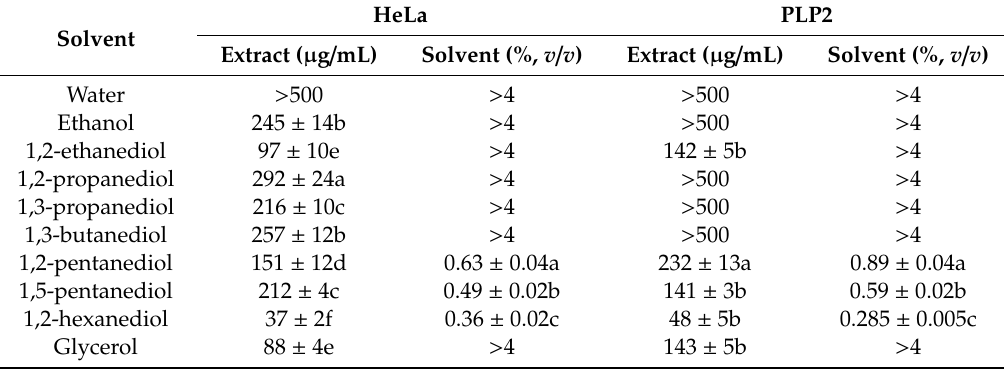
Table 3. Bioactive properties of J. regia leaves. Cytotoxicity in human tumor cell lines HeLa and non-tumor liver primary cells PLP2 (GI 50 ). Quantification for extracts and solvents (mean ± SD). HeLa PLP2 Solvent Extract ( µ g / mL) Solvent (%, v / v